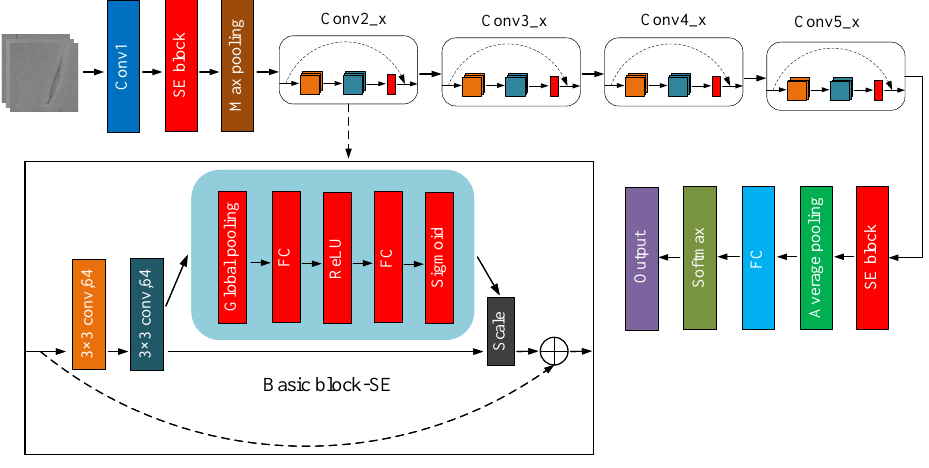
Figure 4. The proposed Multi-SE-ResNet34 model.